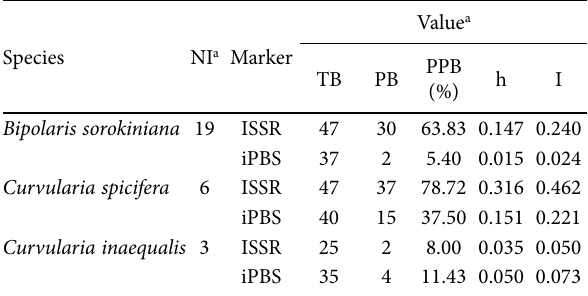
Table 4. Genetic variation values for three fungal species, from ISSR and iPBS